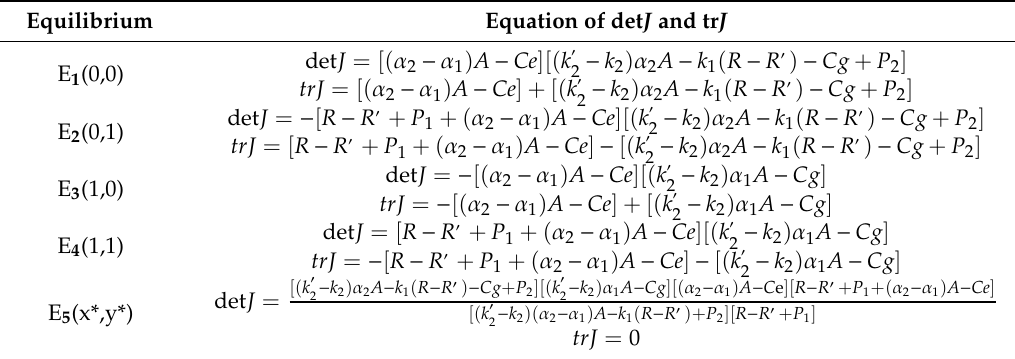
Table 4. Equation of det J and tr J of five possible equilibrium points.